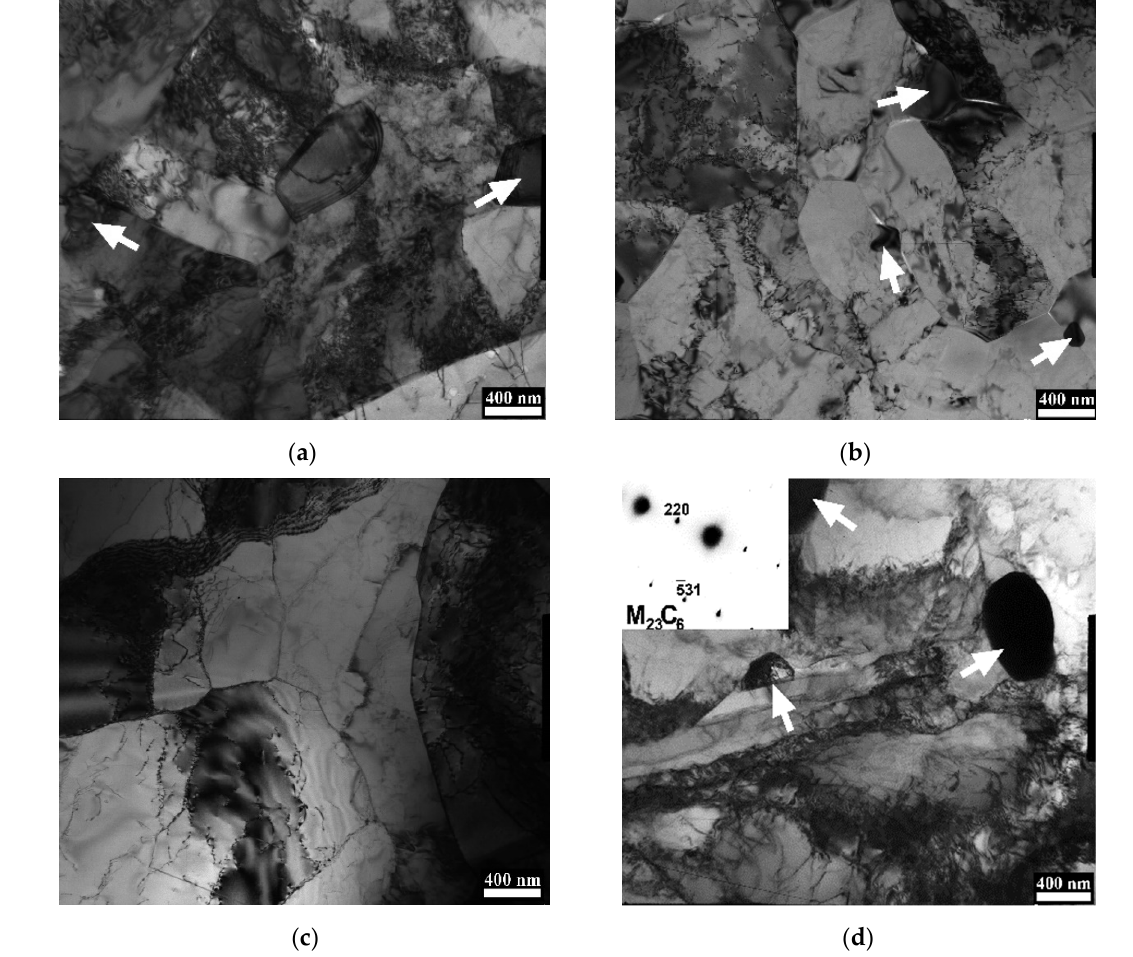
Figure 6. Bright-field TEM images of the stir zone obtained in the following specimens: ( a ) 400-50; ( b ) 400-100; ( c , d ) 600-100. Selected area diffraction patterns taken from a М 23 С 6 carbide is inserted in ( d ).